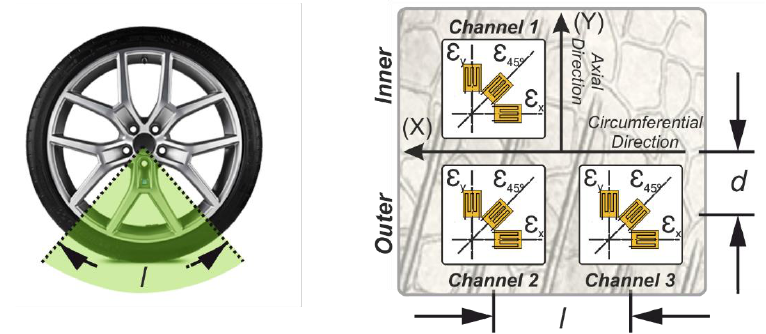
Figure 2. Multiaxial strain gauge disposition.